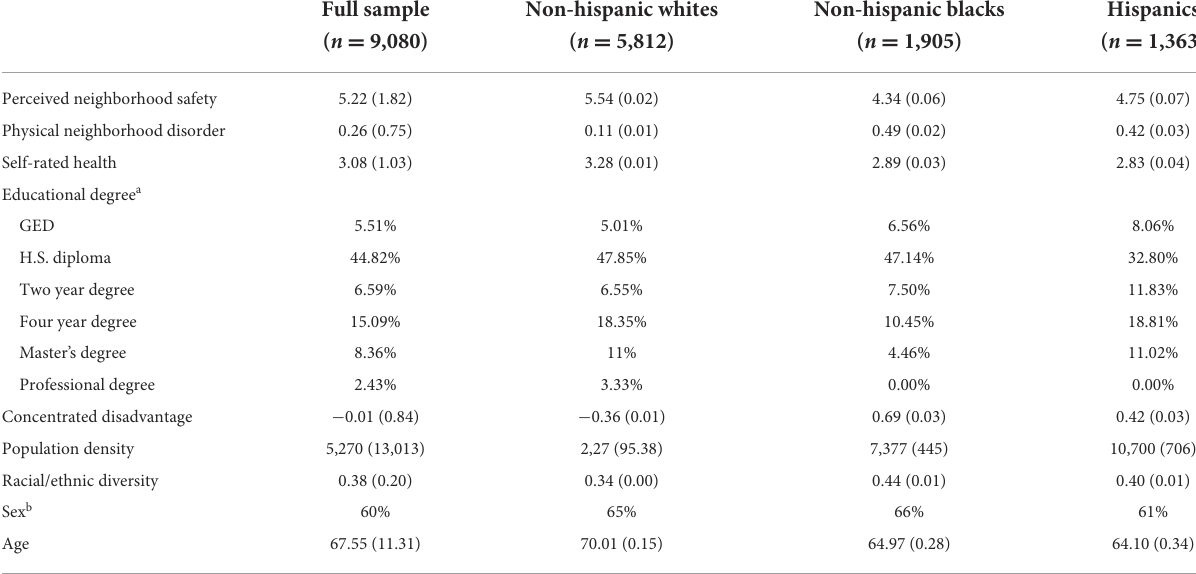
TABLE 1 Descriptive statistics, full sample and stratified by race/ethnicity, [mean